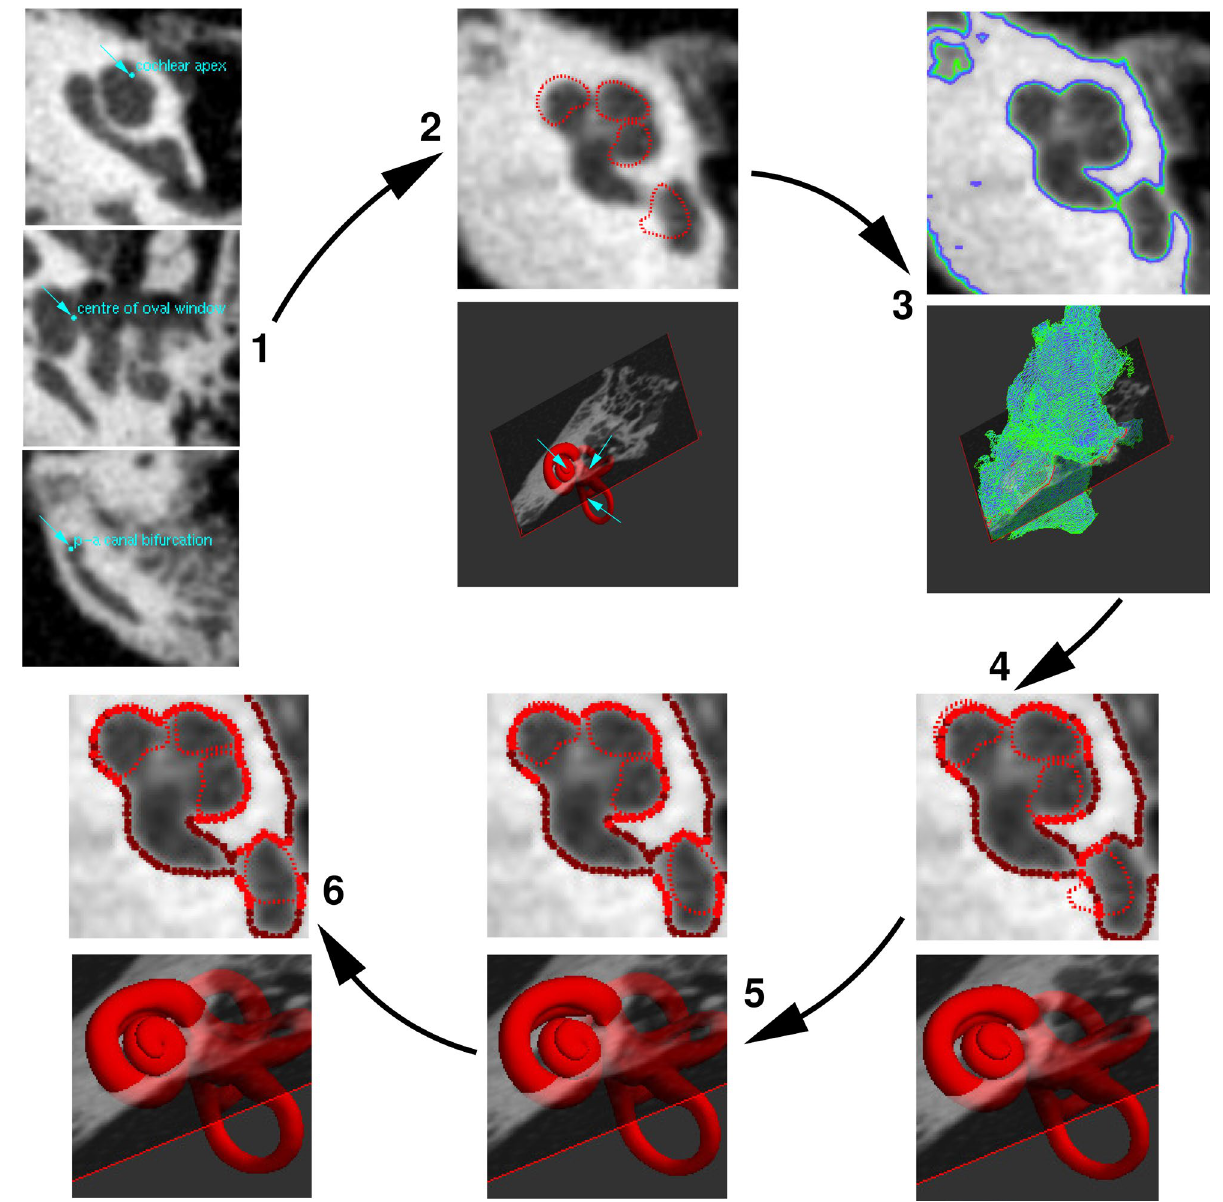
Figure 3. Fitting a model to CT data. (1) The operator scrolls through the axial CT images and places landmarks at the cochlear apex, the centre of the oval window and the posterior-anterior canal bifurcation (at the tip of the crus commune). (2) These landmarks are matched with corresponding, predefined landmarks on the model. An initial, approximate alignment is provided by the similarity transformation (rigid body plus uniform scaling) that minimizes the sum of the squared distances between the three pairs of landmarks. (3) The operator selects a suitable segmentation threshold: this subfigure shows contours thresholded at grayscale 160 (green), 170 (cyan) and 180 (purple). (4) The contour vertices at the selected threshold (170 in this example) provide the point cloud to which the model is fitted. Points closest to a model vertex are displayed in bright red, other points in dark red. (5) Iterative closest point (ICP) registration of the model to the point cloud, with a similarity transformation. (6) Finally, the fit is refined using ICP registration with a nonrigid transformation, either a statistical shape model or a locally affine of the basal turn as the mean absolute distance between the first 270 ◦ of the outer wall contour and the basal plane. The hypothesis is that cochleas with lower non-planarity are less susceptible to insertion trauma than those with higher non-planarity. The consensus approach to cochlear coordinate systems 36 is somewhat ambiguous, in that the basal plane is assumed to be perpendicular to the modiolus. By anchoring our coordinate system to the basal plane and not the modiolus, we break from the usual interpretation and, unfortunately but inevitably, hinder comparability with previous studies.